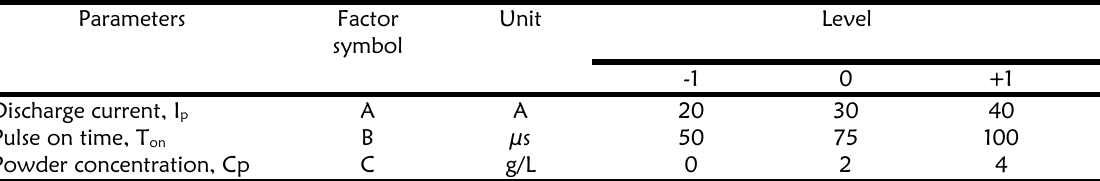
Table 3: PMEDM parameters effect and levels for CCD